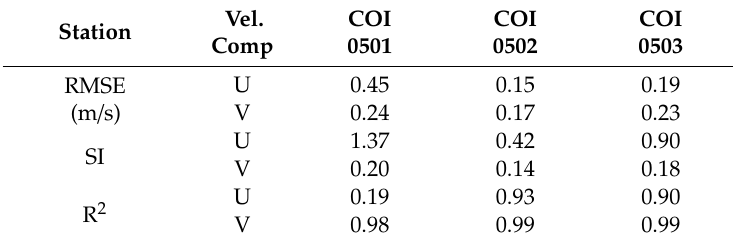
Table 3. Error statistics (RMSE, SI, and R 2 ) for depth-averaged tidal currents at three ADCP survey stations in the Foreland region (The top row is for the east (U) velocity component and the bottom row is for the north (V) velocity component). The model results are from the sensitivity test.